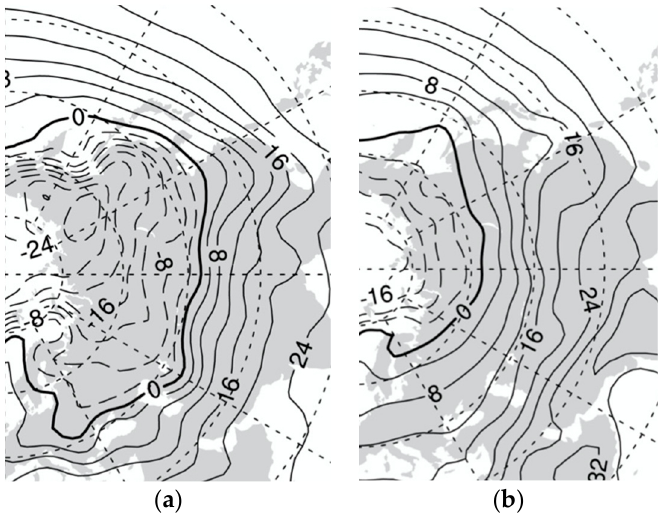
Figure 5. Mean air temperature (1980–2020) in Eurasia in December ( a ) and April ( b ).